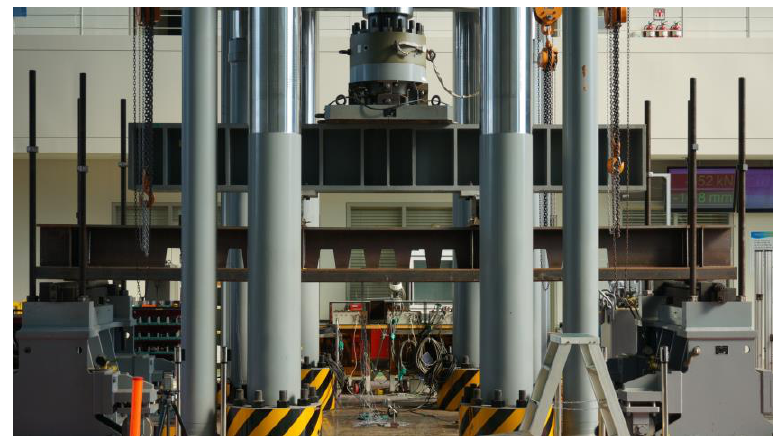
Figure 8. Photo of the actual test setup.